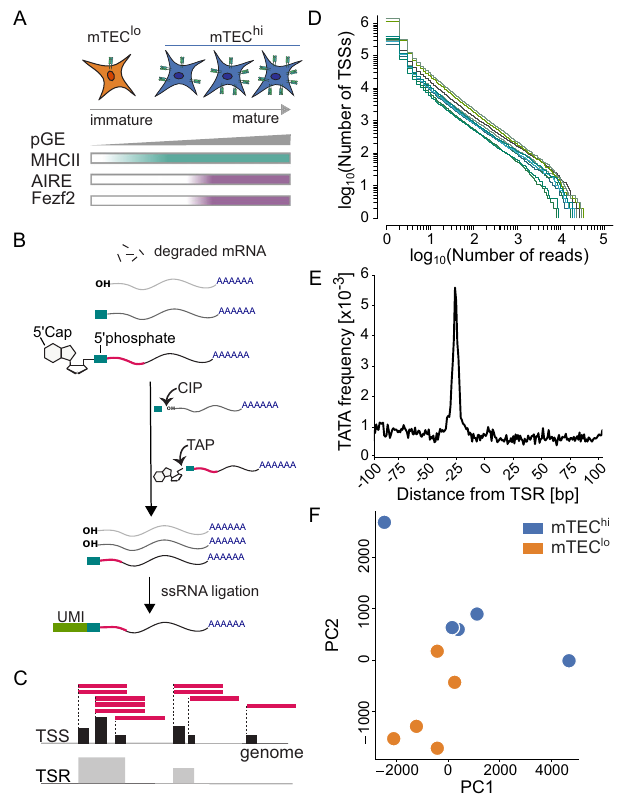
Fig. 1 Overview of mTEC transcription start regions identi fi ed by 5 ’ Cap sequencing. A Medullary thymic epithelial cells (mTECs) undergo a maturation process that is characterized by the levels of promiscuous gene expression (pGE), MHCII expression, and expression of transcription factors AIRE and FEZF2. B Schematic overview of the 5'Cap sequencing method. As previously described 39 – 41 , transcripts with a 5'Cap were isolated using calf intestinal phosphatase (CIP) and tobacco acid pyrophosphatase (TAP) prior to single-stranded RNA (ssRNA) ligation, incorporation of unique molecular identi fi ers (UMIs), and further library preparation. C Following next-generation sequencing, reads were aligned and the number of transcription start sites (TSSs) detected using 5'Cap sequencing were counted at each genomic position. Nearby TSSs were clustered into transcription start regions (TSRs). Distribution of TSSs identi fi ed using 5'Cap sequencing followed D a power-law distribution (colors represent samples) and E enrichment of TATA motifs for TSRs were concordant with those identi fi ed in the RefTSS database 45 . F Principal component (PC) analysis shows clustering of mTEC hi ( n = 5) and mTEC lo samples ( n = 5). Source data for E and F are provided in the Source Data fi